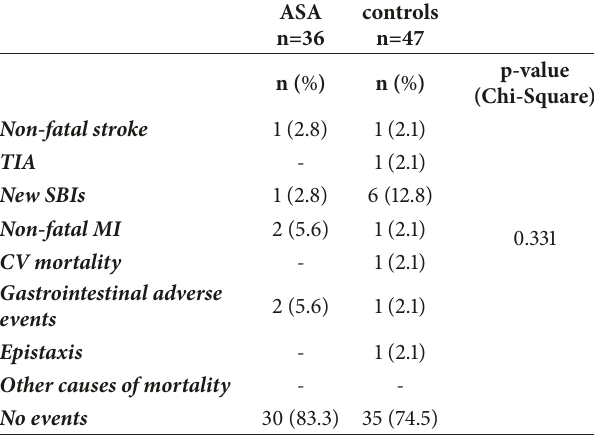
Table 3: Secondary endpoint-a occurrences (all cardiovascular events, SBIs and adverse events).